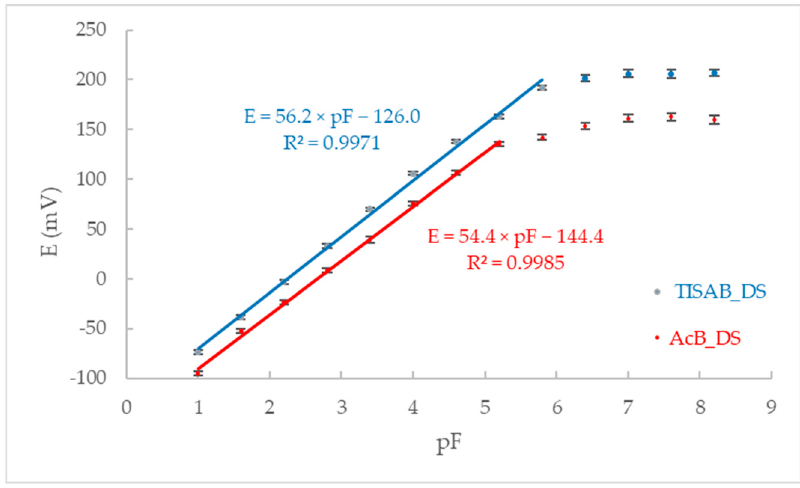
Figure 1. Calibration curves for fluoride ions in experiments performed in AcB_DS and TISAB_DS using commercial FISE.